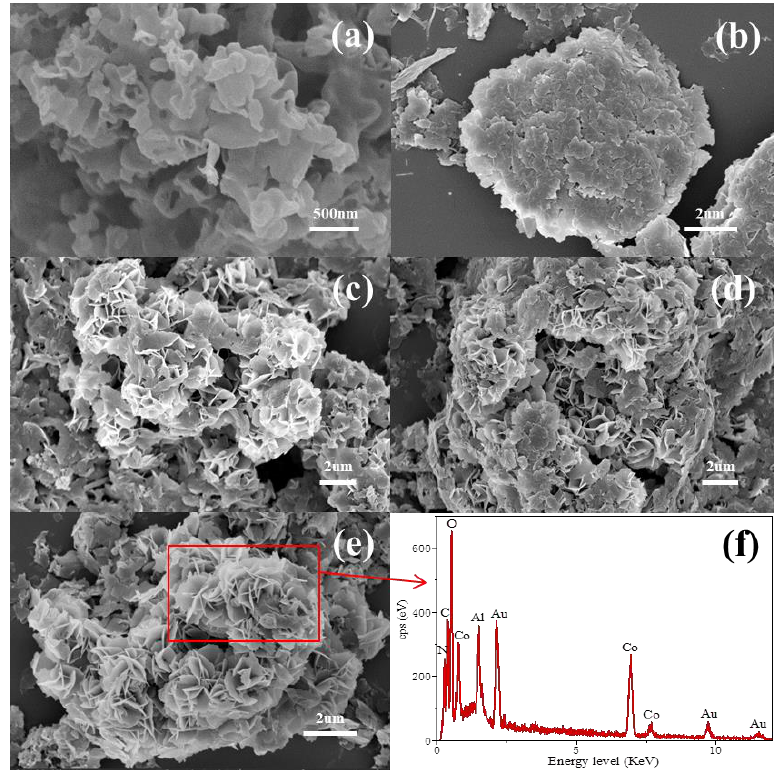
Figure 2. SEM images of: ( a ) g-C 3 N 4 ; ( b ) CoAl-LDH; ( c ) g-C 3 N 4 /CoAl-LDH 0.75 ; ( d ) g-C 3 N 4 /CoAl- LDH 1.25 ; ( e ) g-C 3 N 4 /CoAl-LDH 1. 5 ; ( f ) EDS of g-C 3 N 4 /CoAl-LDH 1.5